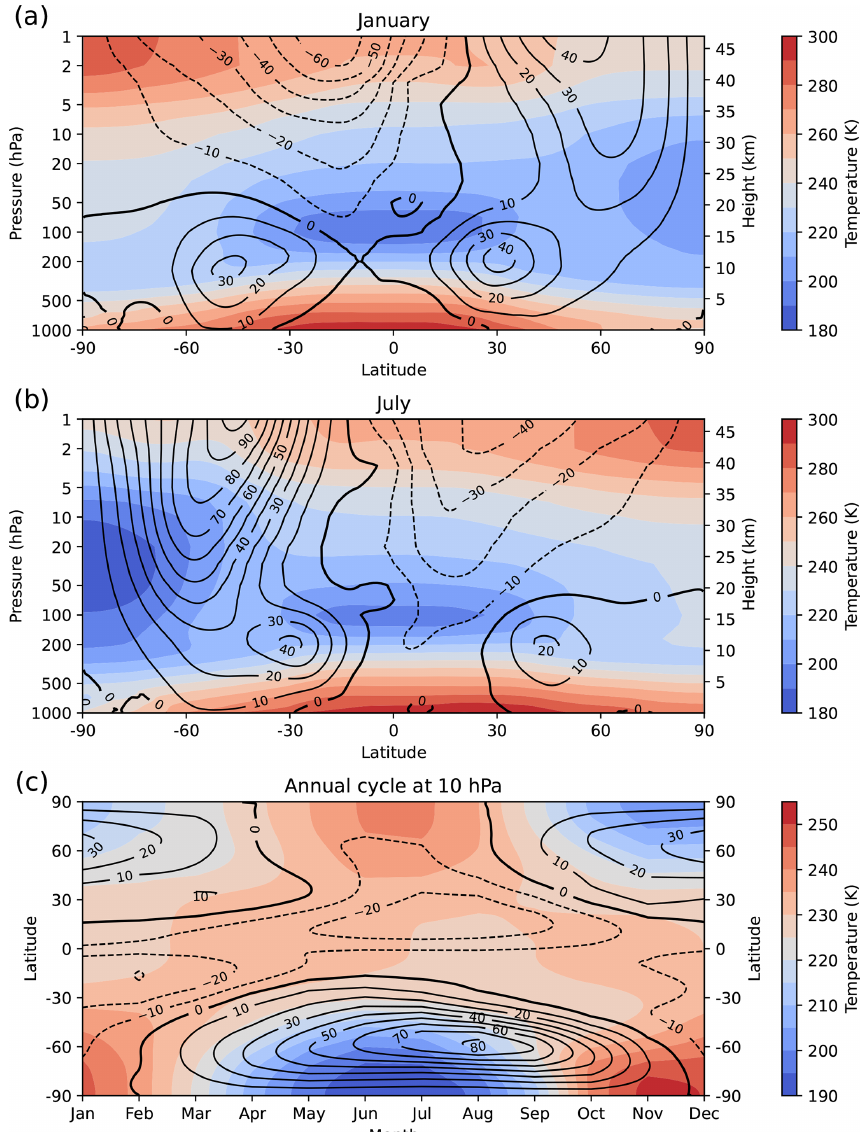
Figure 2. Zonal and monthly mean 1979–2020 climatology based on 6-hourly ERA5.1 reanalyses data (Hersbach et al., 2020) for temperature (K; colour shading) and zonal winds (ms − 1 ; black contours) for (a) January, (b) July and (c) the annual cycle at 10hPa. The contour interval for the winds is 10ms − 1 , with negative values indicated by dashed contours. Data kindly retrieved from the ERA5 archive and processed by Martin